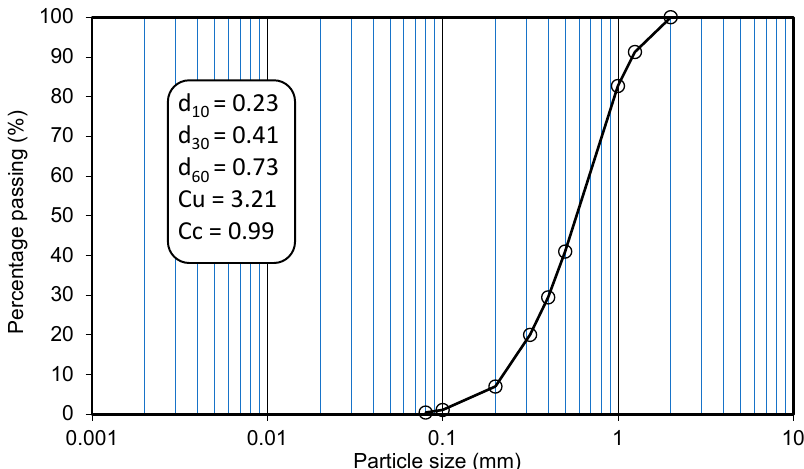
Figure 1. Particle size distribution curve of the sand used. Table 3. Properties of clay used.